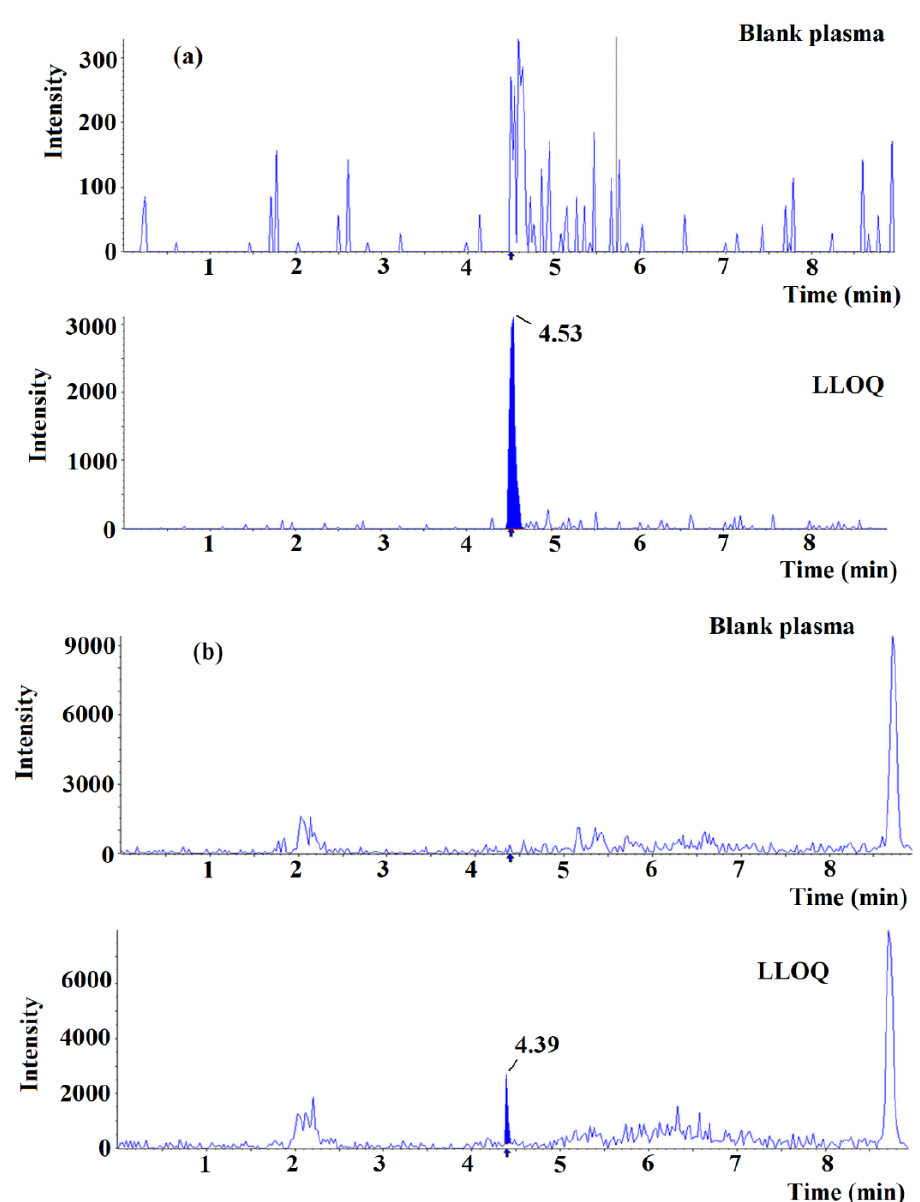
Figure 6. Extracted chromatogram of ANT ( a ) and ANT-OH ( b ) in blank plasma and lower limit of quantitation (LLOQ).